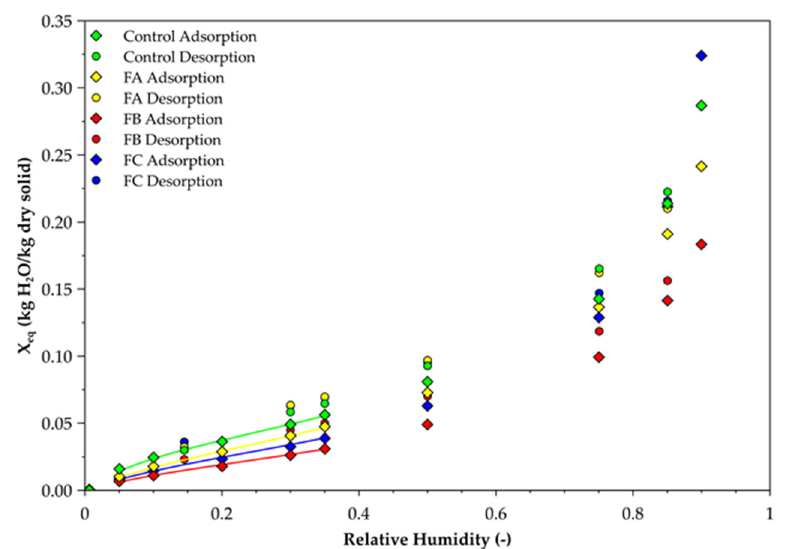
Figure 6. Moisture adsorption and desorption behaviour on Van Soest fraction at 23 °C. Number of repetitions = 2; SD max = 3.5%.